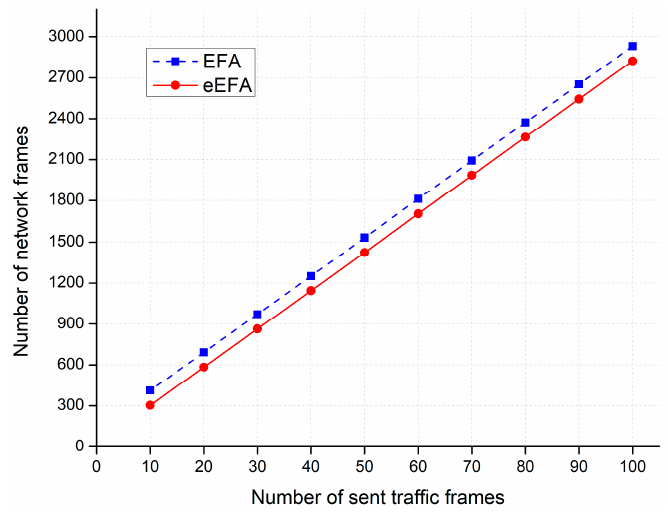
Figure 10. Result of Simulation 1.